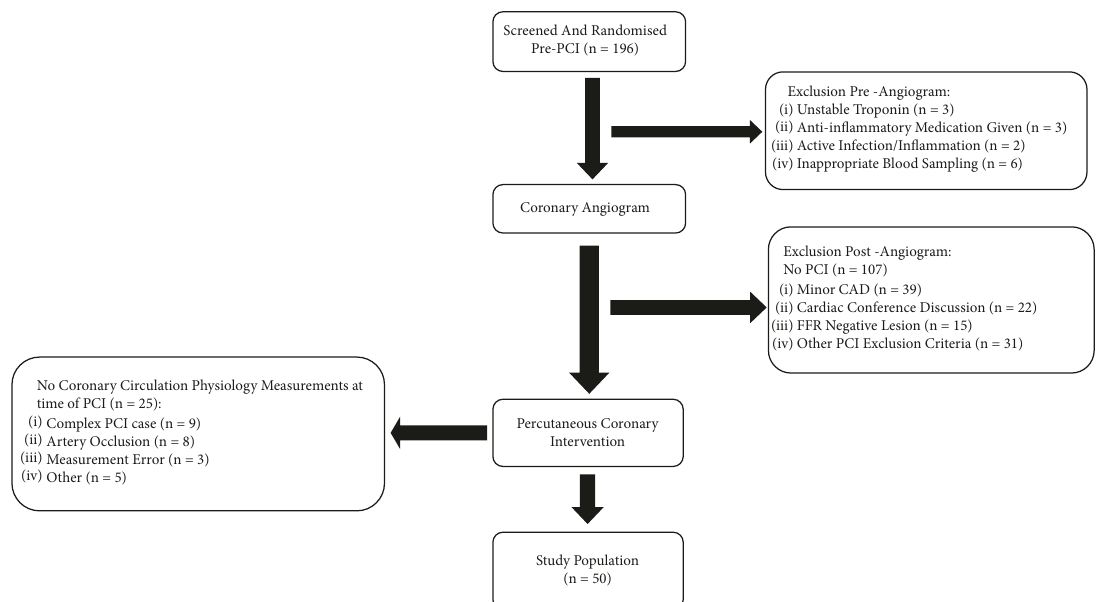
Figure 1: Overview of study design and patient allocation. (i) Development of unstable troponin or active inflammation/infection, anti- inflammatory medications given, or inappropriate blood sampling occurred in 14 patients after randomization. (ii) Cardiac conference discussion patient had severe CAD at coronary angiography. The procedure was therefore stopped, and the patient’s case was discussed at (cid:30) a later date at a combined cardiology/cardiothoracic surgical meeting to determine an optimal revascularization strategy. Most patients were sent for coronary artery bypass grafting. (iii) Other PCI exclusion criteria see “exclusion criteria” in the supplemental material. (iv) (cid:30) Complex PCI case as deemed by the interventional cardiologist, not appropriate for coronary artery physiology measurements. (cid:30) Table 1: Baseline patient characteristics and pre-PCI medication use, by study drug randomization. Baseline